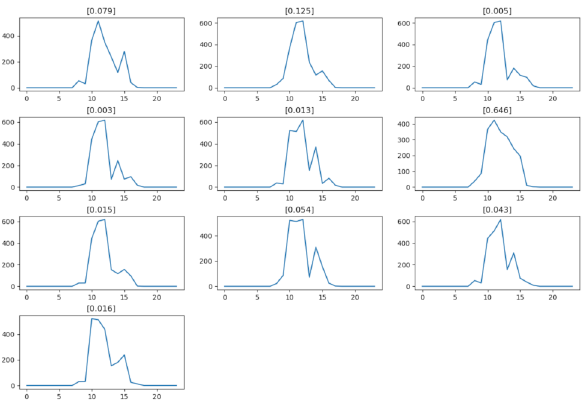
Figure 12. Ten preserved scenarios of solar irradiance for winter season with probability of occurrence in the